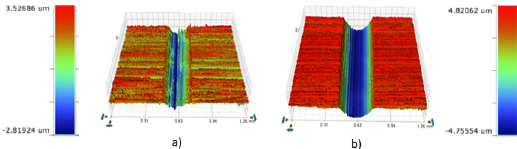
Figure 13: Profilometry results for the cryogenic quenching (-196 °C) sample in a) dry condition and b) corrosive